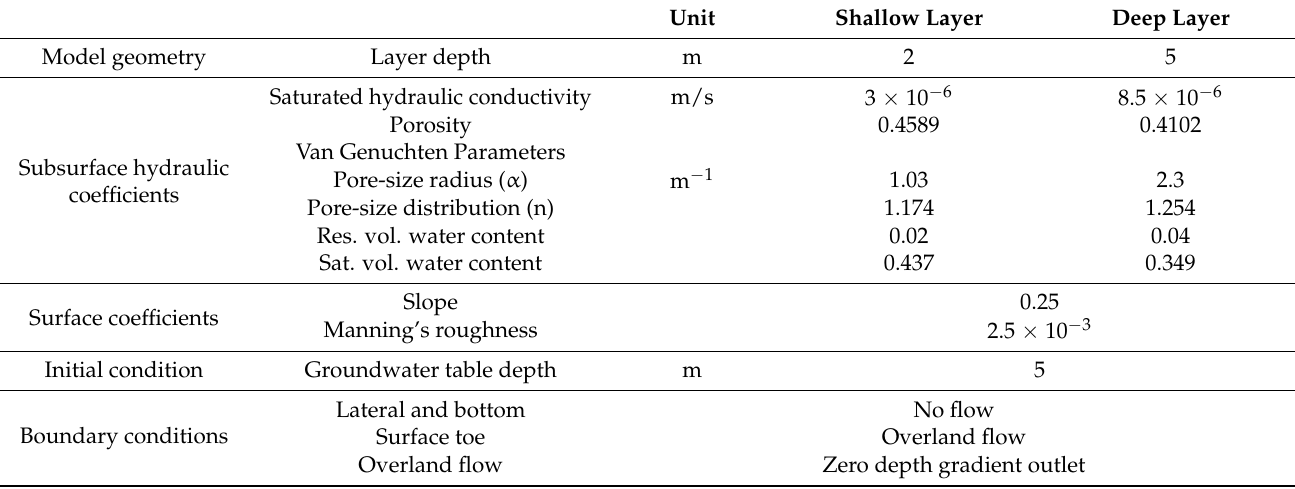
Table 5. Parameters in the DYK cases.